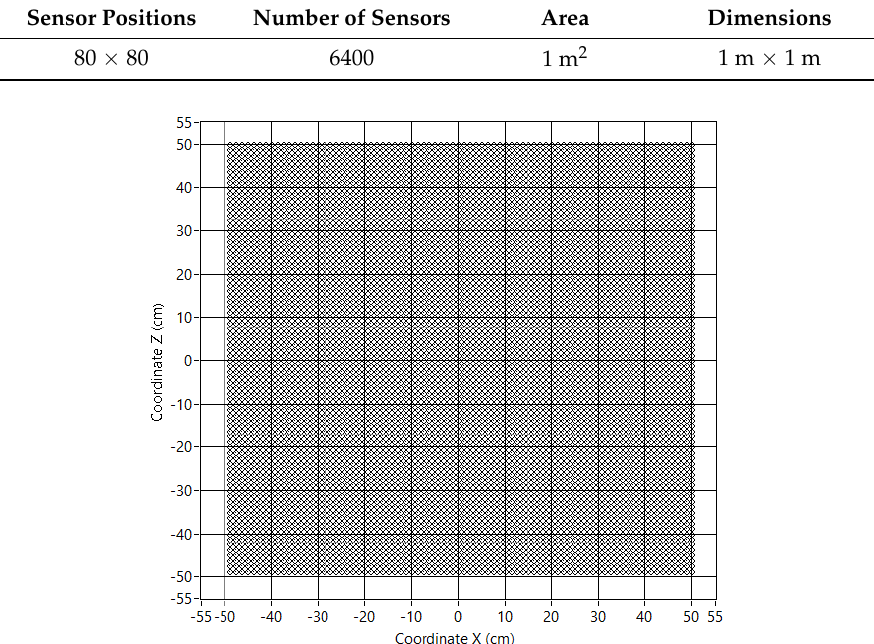
Figure 5. Virtual array sensor positions.